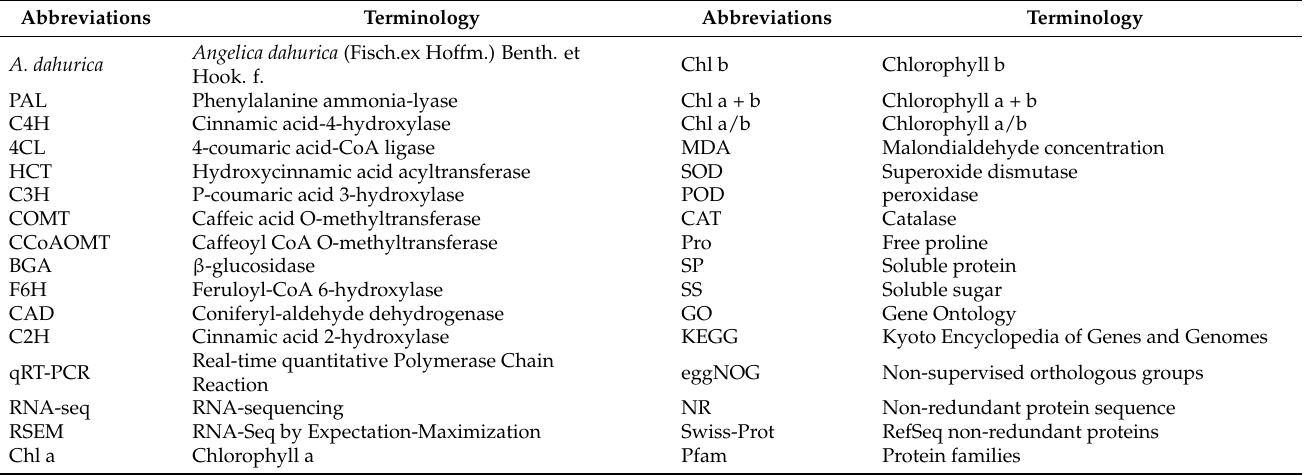
Table 1. Glossary of abbreviations for professional